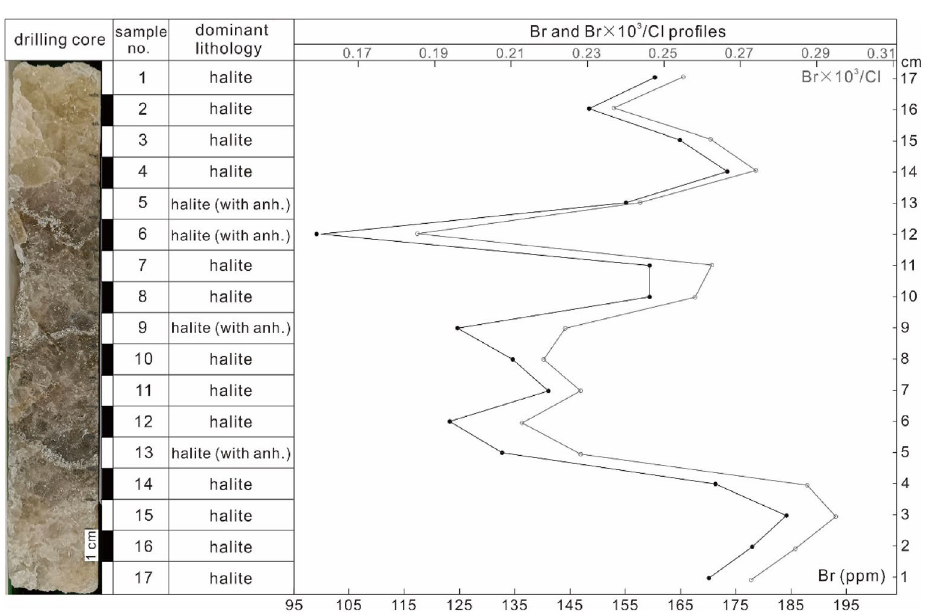
Figure 4. The bromine profile of a halite interval from a drilling core in the Khorat Basin. anh. anhydrite; solid circle: Br content; hollow circle: Br × 10 3 /Cl